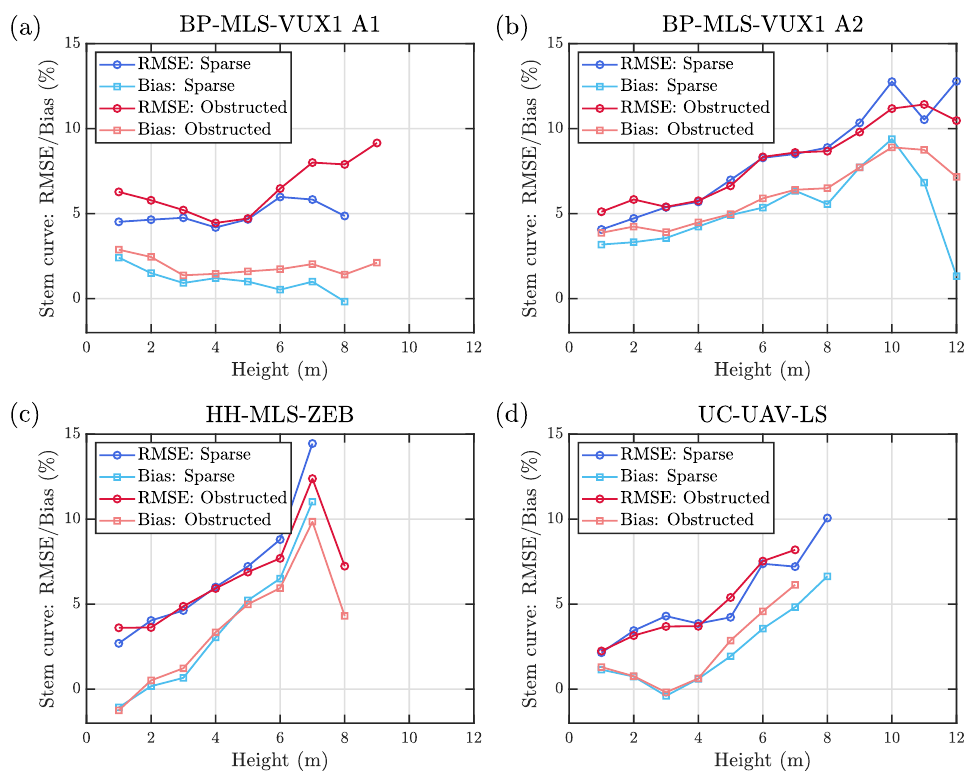
Figure 10. Relative bias and RMSE of the stem curve estimates as a function of height from the ground level for ( a ) the data collected with the backpack BP-MLS-VUX1 system and processed using the 2D arc extraction algorithm, ( b ) the data collected with the backpack BP-MLS-VUX1 system and processed using the 3D arc extraction algorithm (A2), ( c ) the data collected with the handheld HH-MLS-ZEB system and processed using the 3D arc extraction algorithm, and ( d ) for the data collected with the under-canopy UC-UAV-LS system and processed using the 3D arc extraction algorithm. Note that the bias and RMSE of the stem curve estimates are shown for all the height intervals, for which the stem curve could be estimated for at least 5 trees within each